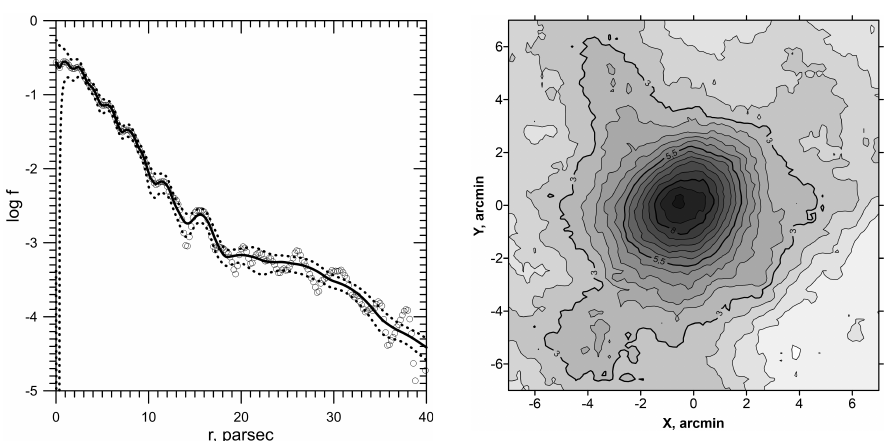
Fig. 1. Left-hand panel : the adaptive kernel estimate (the solid line) and the fixed kernel estimate used as a pilot estimate for the adaptive method (the open circles) of the spatial density profile for the corona of N -body model (Danilov et al. 2014). The dotted lines show the confidence interval for the adaptive estimate. Right-hand panel : the surface density map of the open star cluster NGC 4337, computed using the quartic kernel with a halfwidth of h = 3 arcmin, V lim = 16 mag. The density contour lines are marked in units of arcmin (cid:0) 2